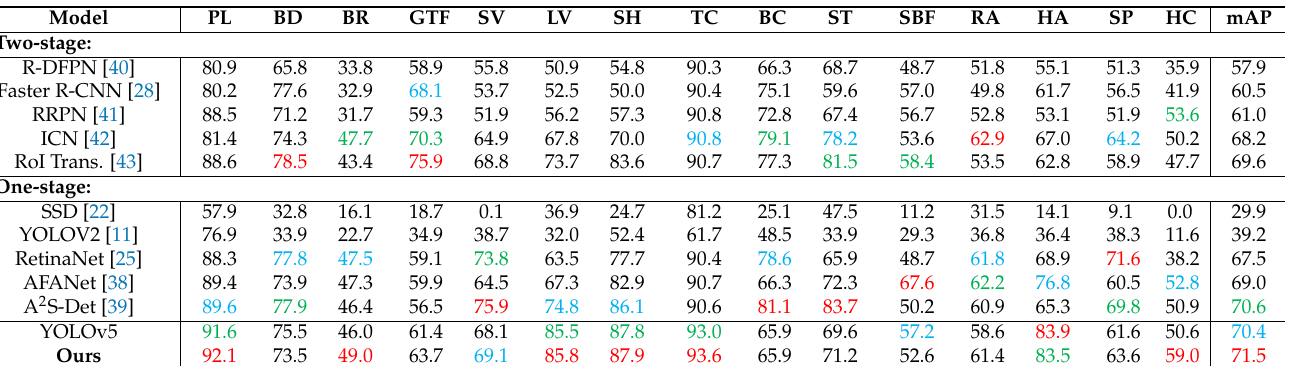
Table 5. The detection accuracy of each category on the DOTA dataset, the detection performance of the best is marked in red, the detection performance of the second-best is marked in green, the detection performance of the third is marked in